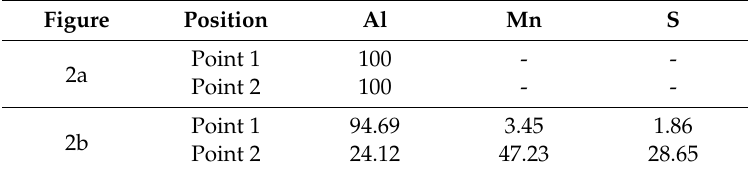
Table 2. EDS point analysis of oxides for the non-treated sample shown in Figure 2 (mass percentage).